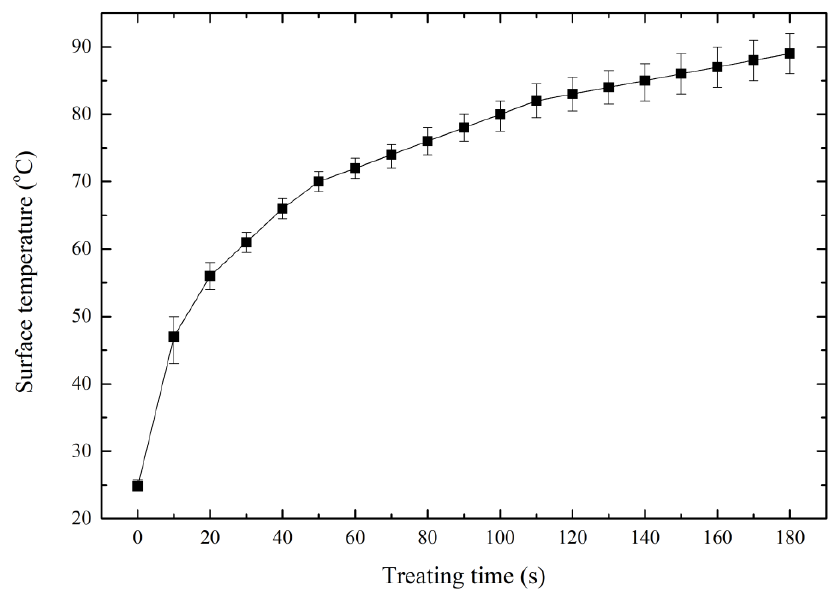
Figure 5. Surface temperature on the PP surface after various plasma treatment times. The thermal camera measured similar surface temperature during treatment time distribution for PET and PE.